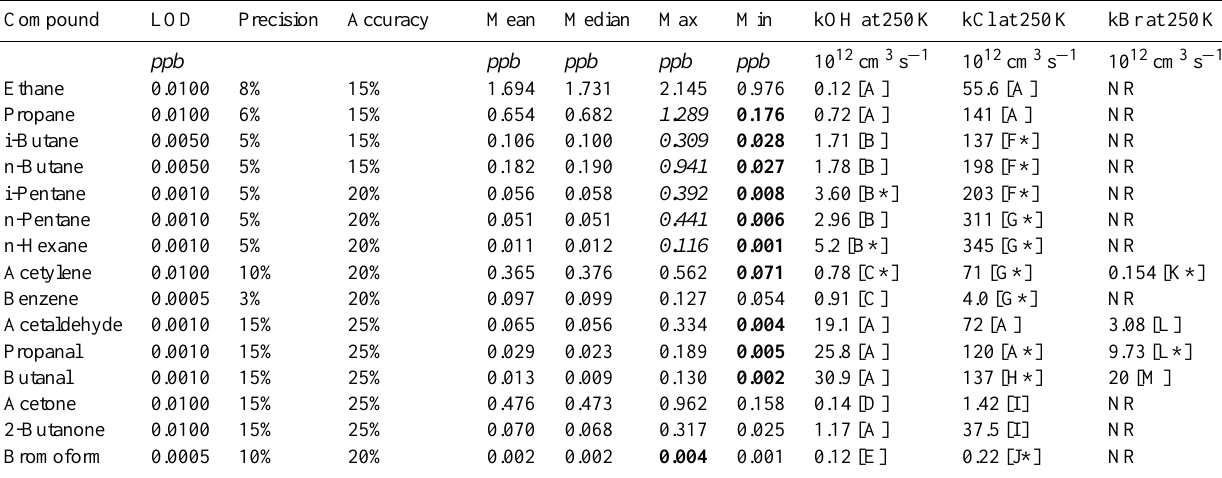
Table 1. Summary of the measurement parameters, statistics, and reaction rate coefficients for OH ( k OH ), Cl ( k Cl ), and Br ( k Br ) with a select group of VOCs measured during ICEALOT. The mean, median, maximum, and minimum values are for the 891 VOC samples in the sub-Arctic and